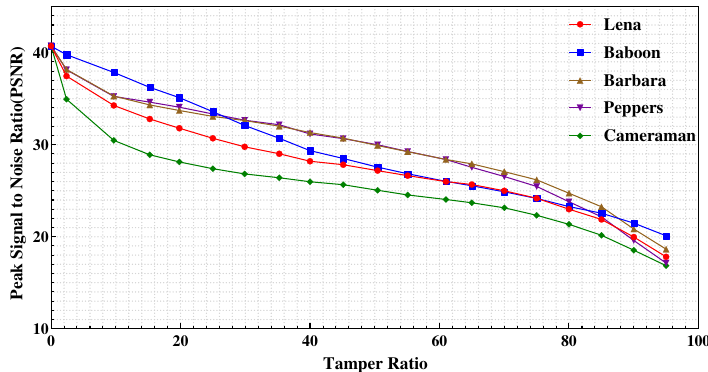
Figure 15. The PSNR of the recovered image relative to the tampered